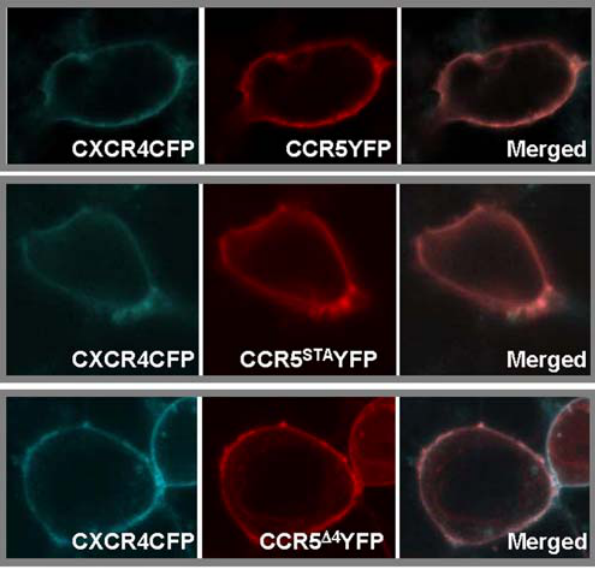
Figure 3. Co-localization of CXCR4 and CCR5 or CCR5 mutants on the surface of living cells. HEK293 cells were co-transfected with CFP-tagged CXCR4 and YFP-tagged CCR5, or CCR5 mutants. Fluores- cence images show distribution of CXCR4CFP (cyan) and CCR5YFP, CCR5STAYFP or CCR5 D 4YFP (red). The merged images are presented to show co-localization.